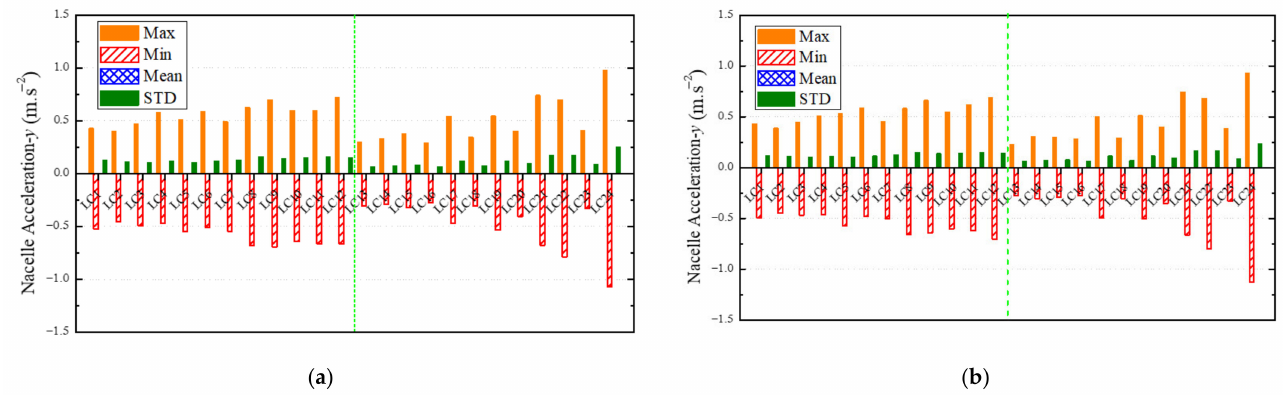
Figure 17. Statistics of nacelle acceleration response in x -direction for ( a ) without current; ( b ) with current.